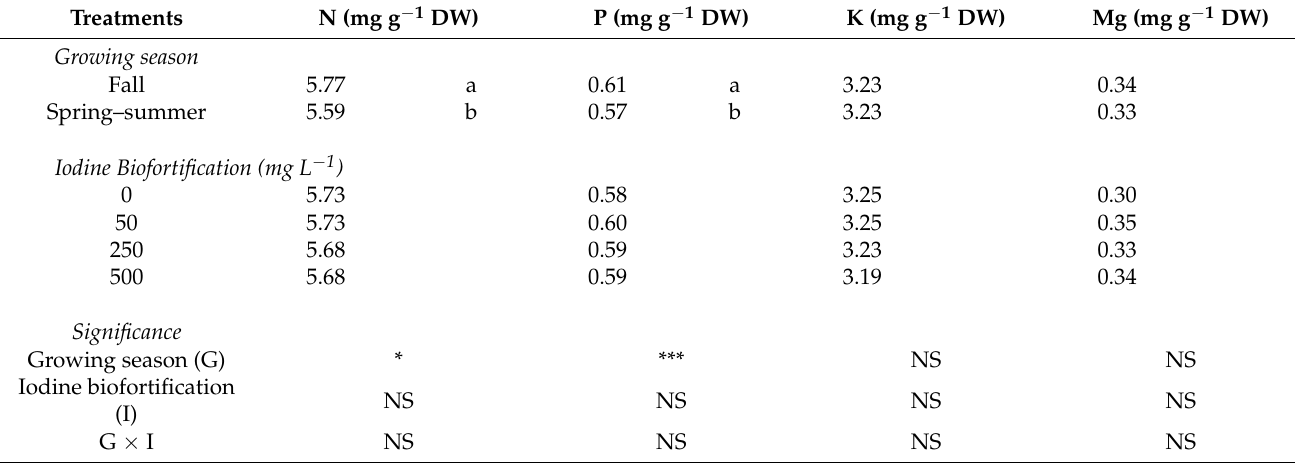
Table 3. Effect of the growing season (fall or spring–summer) and iodine supply (0, 50, 250 or 500 mg L − 1 ) on N, P, K, and Mg concentration in curly endive.